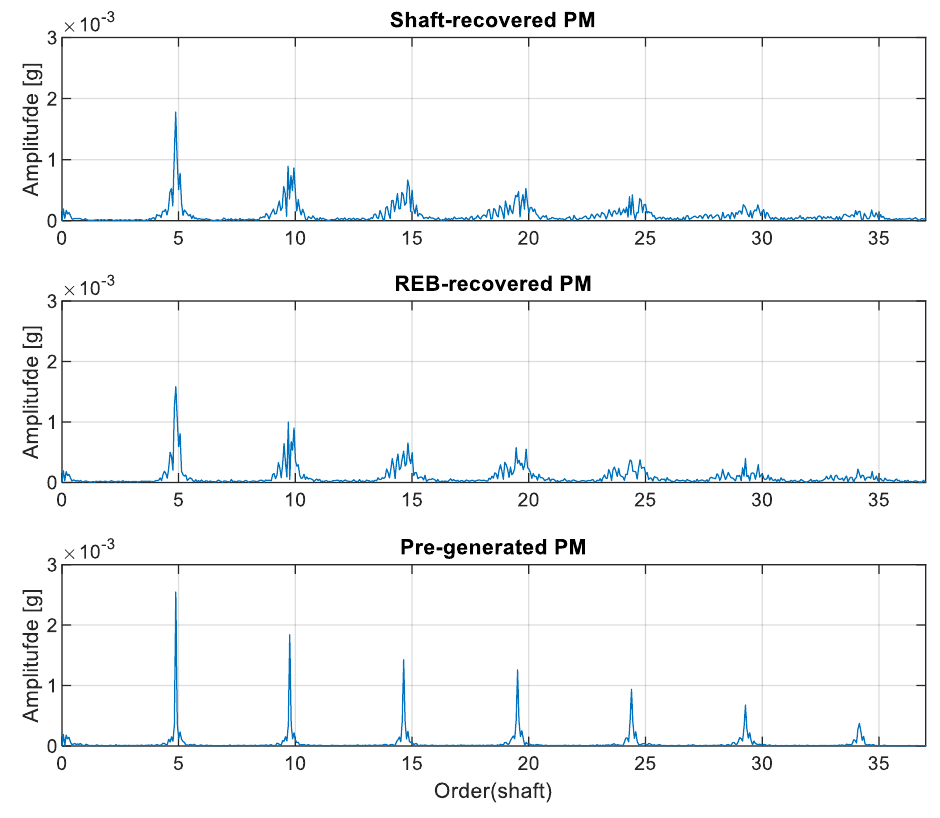
Figure 21. Envelope order spectra.